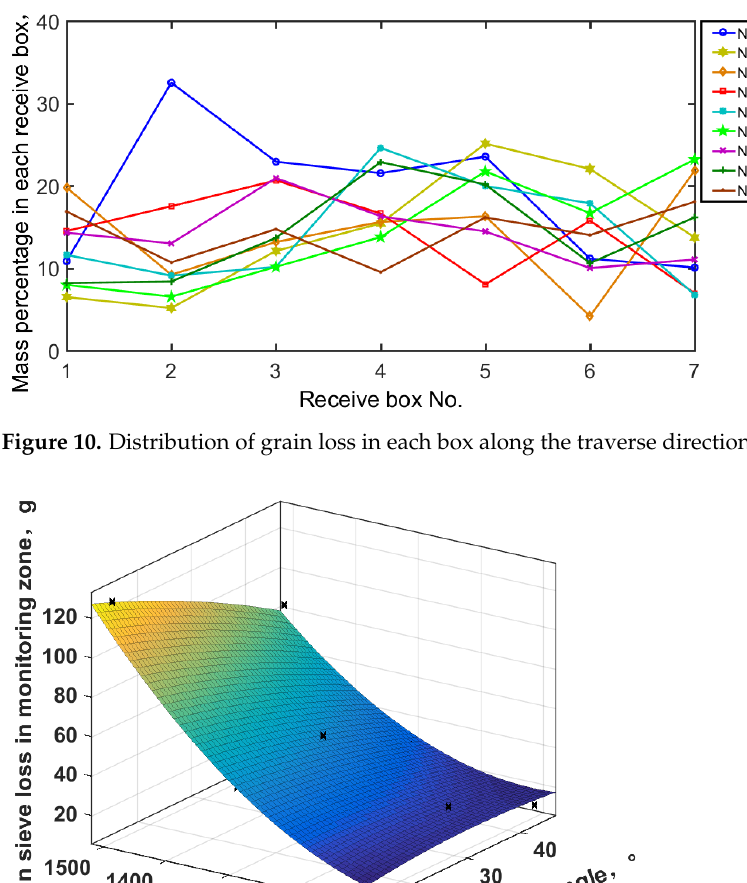
Figure 10. Distribution of grain loss in each box along the traverse direction.